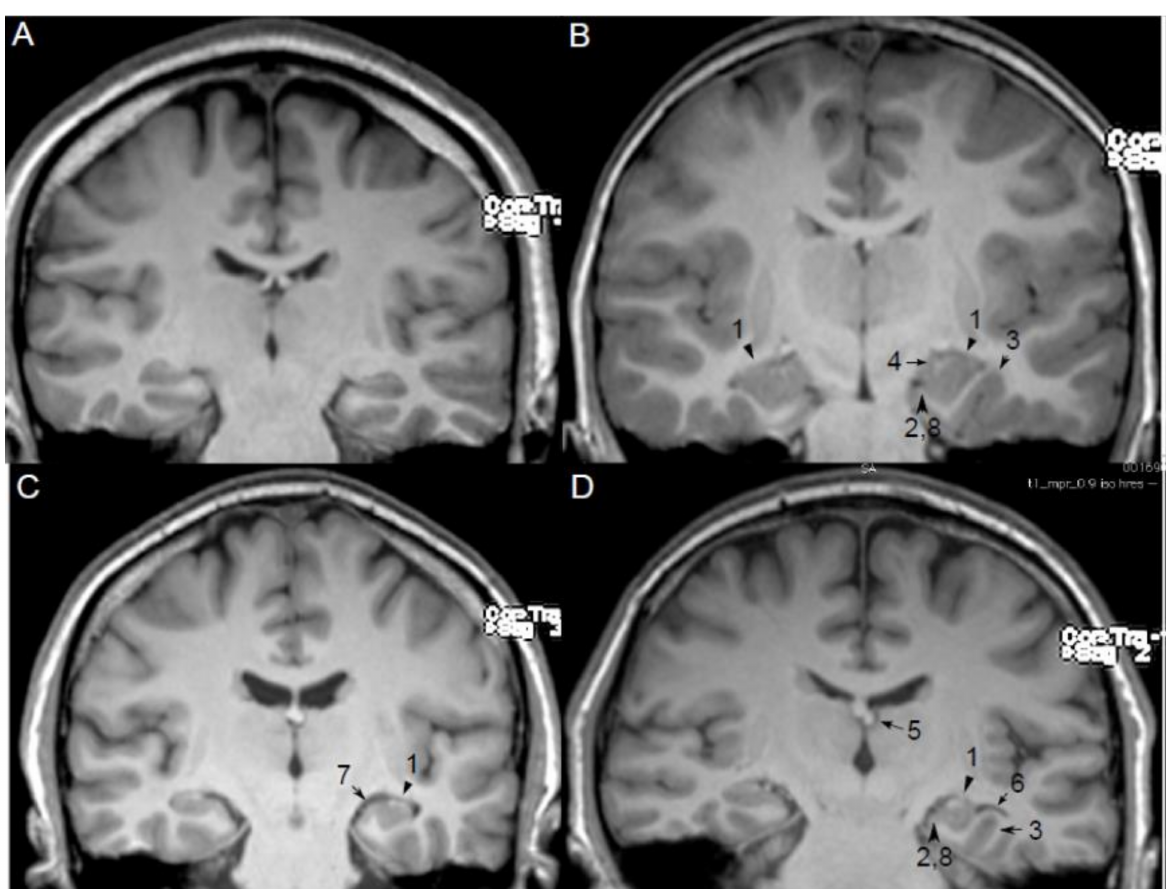
Figure 1. MRI qualitative features of hippocampal malrotation (HIMAL). Figure 1 Legend: ( A ) Normal bilateral hippocam- pus, ( B ) Bilateral HIMAL, ( C , D ) Unilateral HIMAL on left side. 1 Round or pyramidal shape instead of ovoid shape, 2 medial position of hippocampus on hippocampal sulcus, 3 excessively deep or “verticalized” collateral sulcus, 4 medial located fimbria, 5 small or displaced fornix, 6 enlarged temporal horn, and empty choroid fissure, 7 thickened subiculum, 8 reduced upper horizontal portions of the parahippocampal